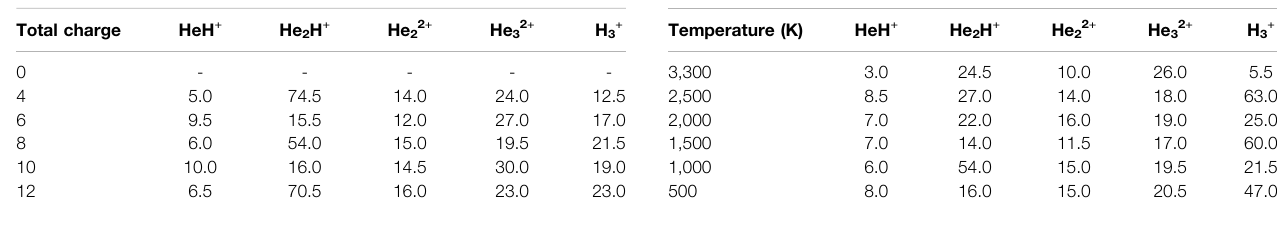
TABLE 4 | Time of occurrence (in fs) of different species from the AINR simulation of 1: 3 ratio of helium to hydrogen while varying total positive charge of the system.